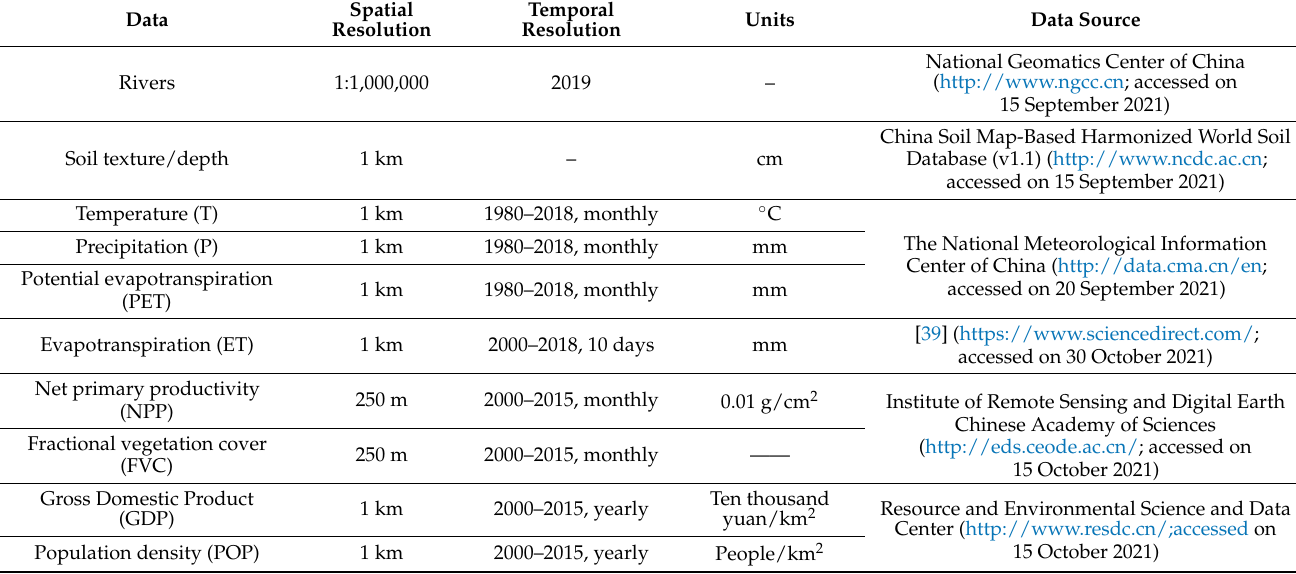
Table 1. Spatial data sources and